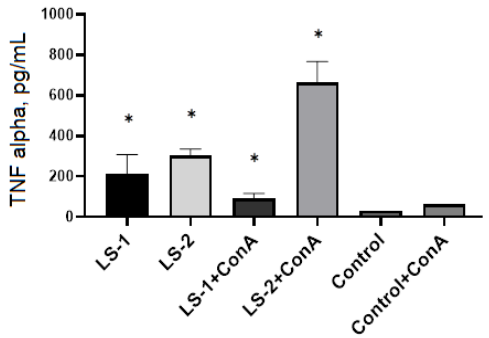
Figure 7. Effects of S. deserta Schang. extracts on the secretion of TNF- α by spleen T lymphocytes. (LS-1)—sage extract obtained by conventional extraction and (LS-2)—sage extract obtained by ultrasonic-assisted extraction. Two controls were used in the experiment: spleen T lymphocytes without treatment or stimulus and spleen T lymphocytes activated with Con A. (*) indicates significant differences in comparison to control, p < 0.05.